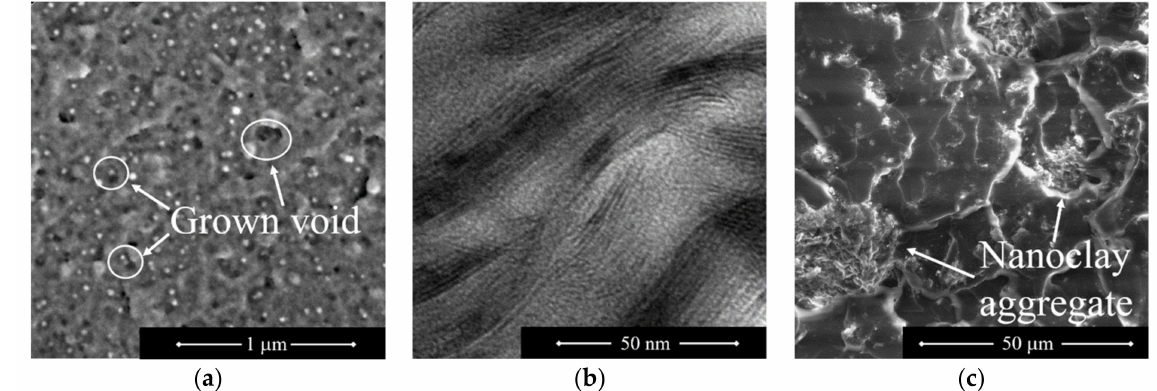
Figure 1. Micrographic pictures of nanoreinforced epoxies. ( a ) Fracture surface of a silica-nanoparticle reinforced epoxy. ( b ) TEM image from a montmorillonite reinforced epoxy. ( c ) Fracture surface of a nanoclay reinforced epoxy. These images were taken from the same batch of those used in